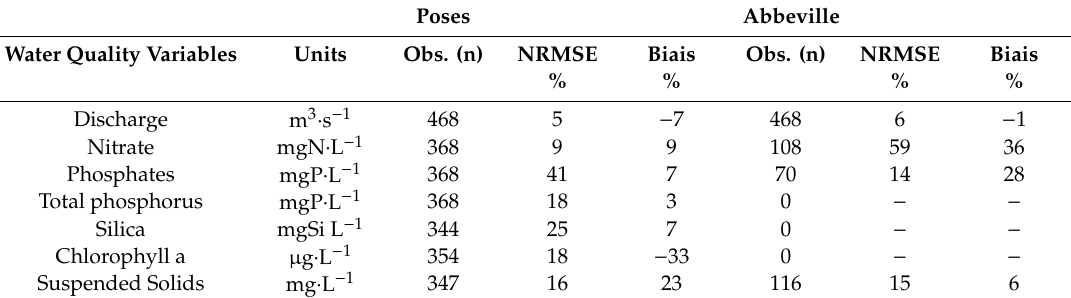
Table 4. Evaluation of GRAFS-RIVERSTRAHLER performance for the Seine River at Poses and Abbeville. The goodness of fit of the simulations with respect to the observed concentration was evaluated for the major water quality variables by calculating the root mean square error, normalised to the range of the observed data (NRMSE), according to the formula (NRMSE = 100 × SQR (1 / n